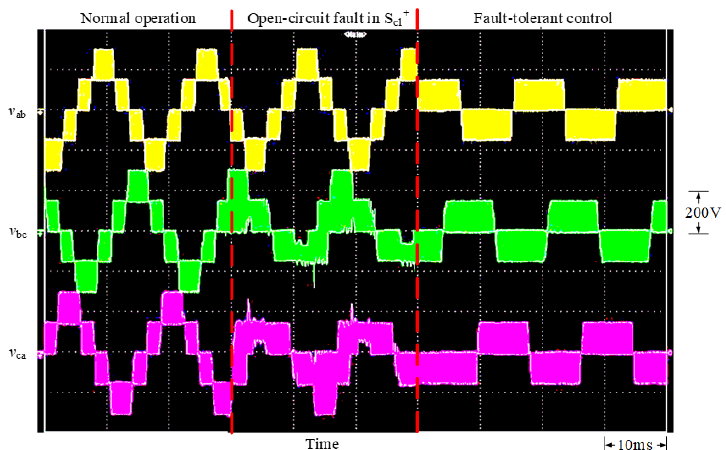
Figure 24. Measured waveform of the output voltage generated by the fault-tolerant control strategy when an open-circuit fault occurs in the switch S c 1+.